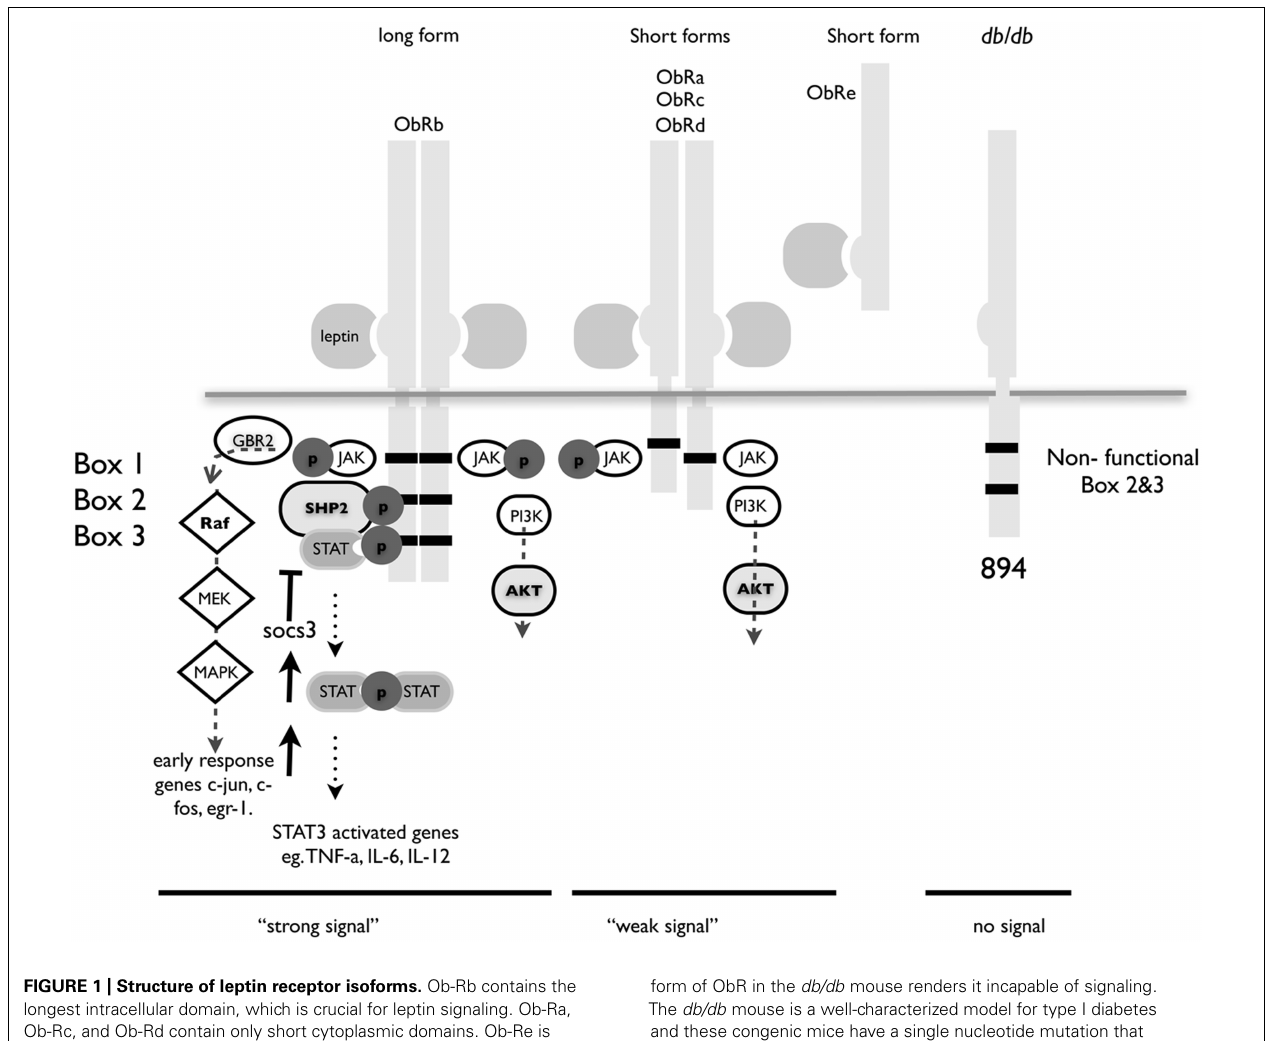
FIGURE 1 | Structure of leptin receptor isoforms. Ob-Rb contains the longest intracellular domain, which is crucial for leptin signaling. Ob-Ra, Ob-Rc, and Ob-Rd contain only short cytoplasmic domains. Ob-Re is truncated at position 830. Box 1 is a JAK docking site, boxes 2 and 3 are STAT docking sites. A point mutation at position 894 in the long